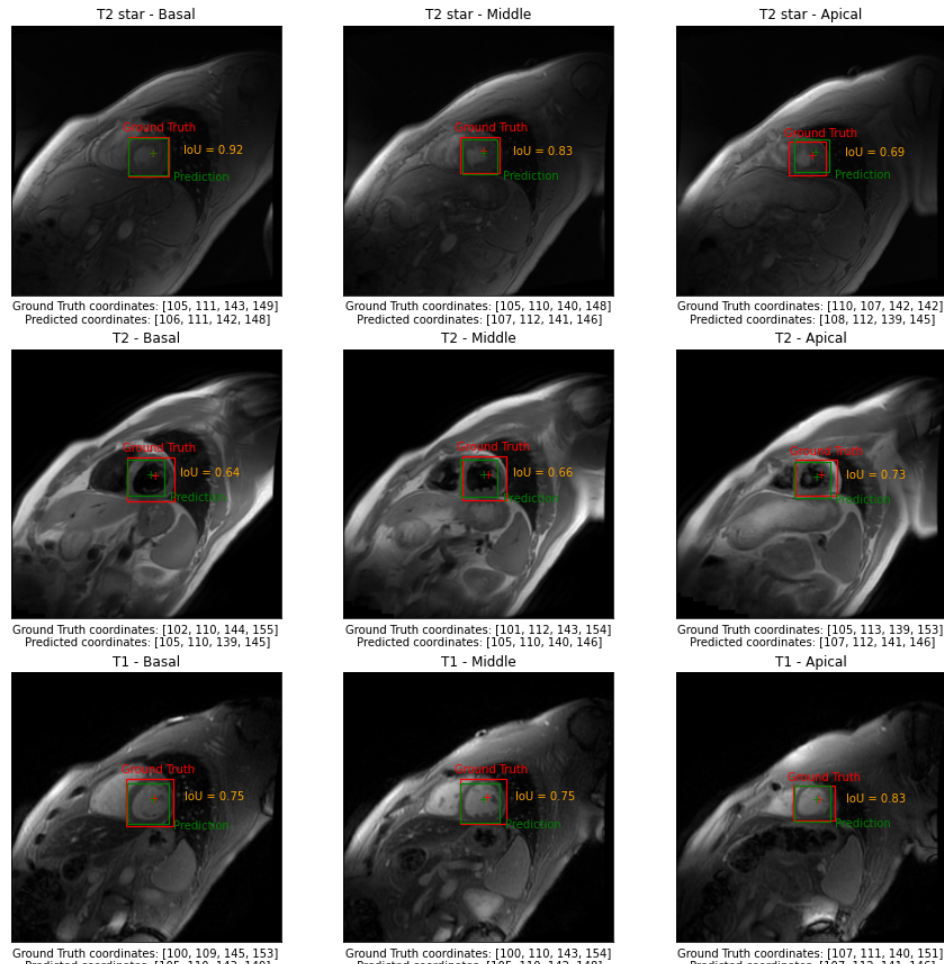
Figure 4. Examples of the model’s output of a selected subject for all three independent test sets in basal, middle, and apical